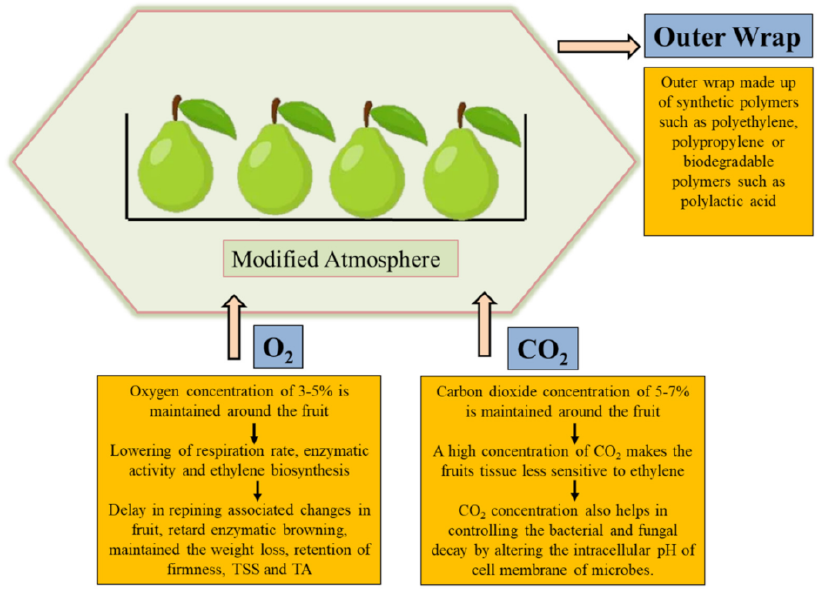
Figure 3. Graphical indication of the mechanism and functions of MAP for improving the shelf life of guava. The low level of oxygen in the MAP packaging is responsible for the retarding the moisture loss, change in color of fruits, and the lower lipid/pigment oxidation. On contrary, the increasing level of carbon dioxide in MAP packaging system of guava fruits has potential to inhibit microbial spoilage while maintaining overall postharvest attributes (modified from: Soltani et al., [73]; Paine and Paine